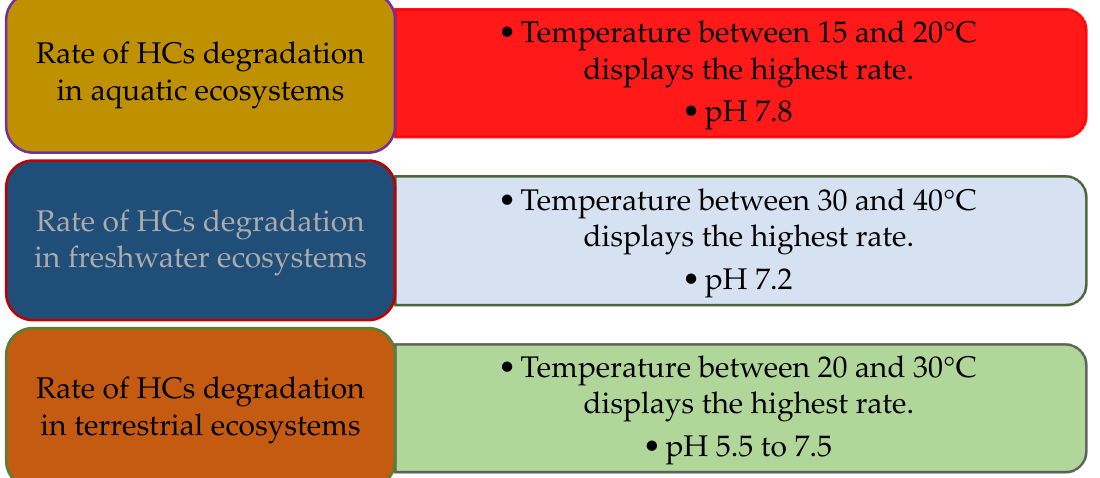
Figure 3. The optimal temperatures and pH for the highest HCs degradation in three ecosystems.